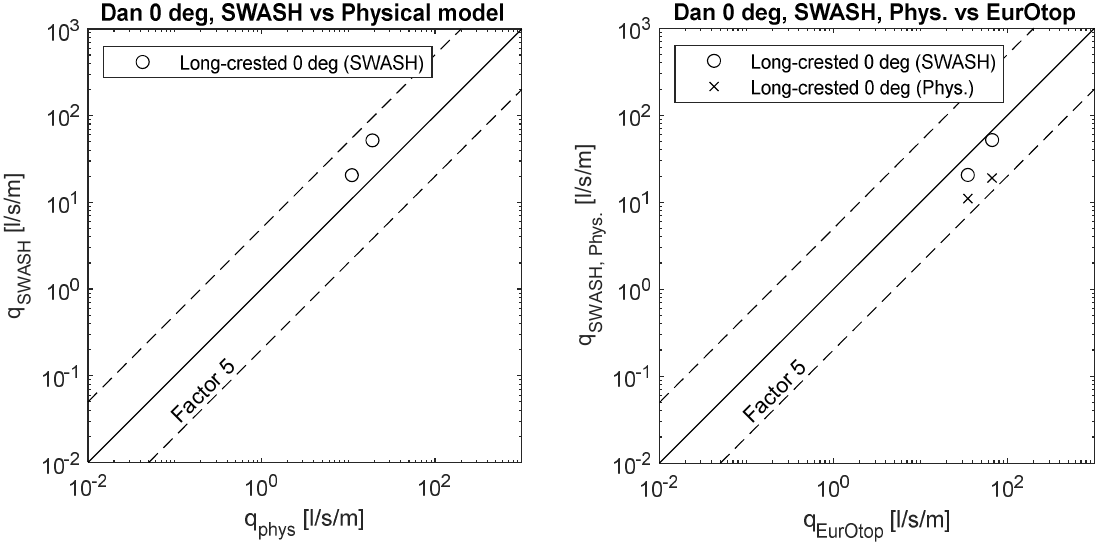
Figure 7. Measured and computed mean wave overtopping discharge (Case D343 and D344: Dan et al. [4] , wave direction 0 degrees). Dashed lines show factor 5 overtopping deviation from 1:1 line (e.g., the upper line crosses 5 l/s/m and the lower line crosses 0.2 l/s/m at the target overtopping discharge 1 l/s/m).